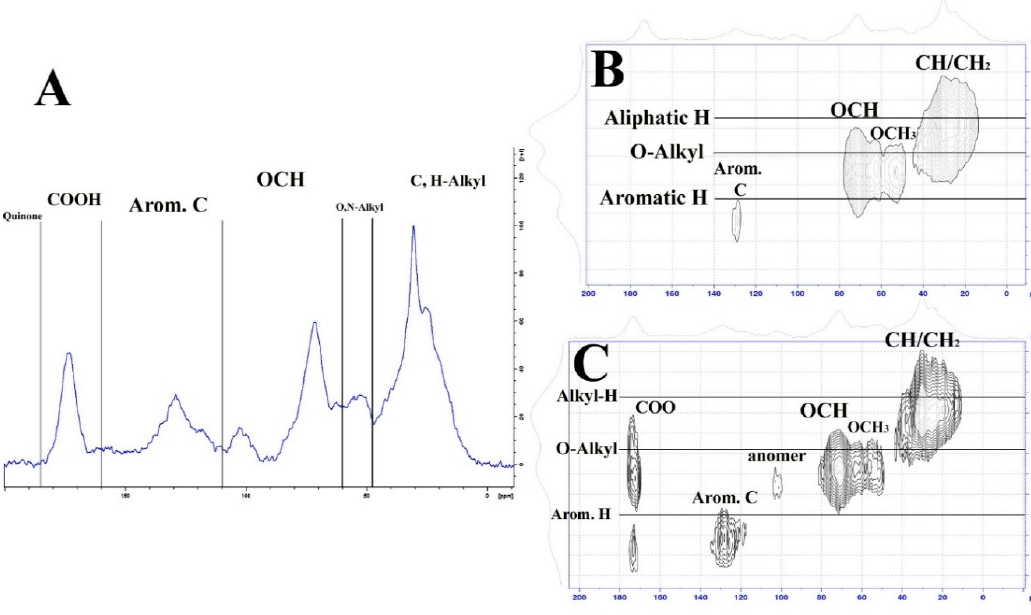
Figure 2. 1 H- 13 C (HETCOR) and 13 C (CP/MAS) NMR spectra of HAs isolated from the soil of the Yamal Yamal peninsula. ( A ) 13 C (CP / MAS) NMR; ( B ) 1 H- 13 C (HETCOR) NMR with contact time 0.1 ms; peninsula. ( A ) 13 C (CP/MAS) NMR; ( B ) 1 H- 13 C (HETCOR) NMR with contact time 0.1 ms; and ( C ) 1 H- and ( C ) 1 H- 13 C (HETCOR) NMR with a contact time 0.75 13 C (HETCOR) NMR with a contact time 0.75 ms.